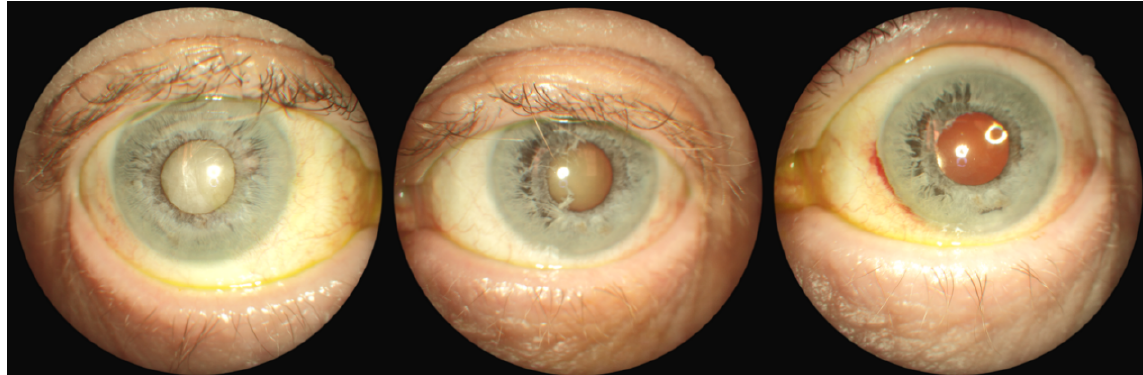
Figure 2: (Left) iridoschisis and cataract right eye; (center) left eye before cataract surgery; (right) after cataract surgery (Canon CR-2 AF Digital Non-Mydriatic Camera, Canon USA, Inc., Lake Success, New York,